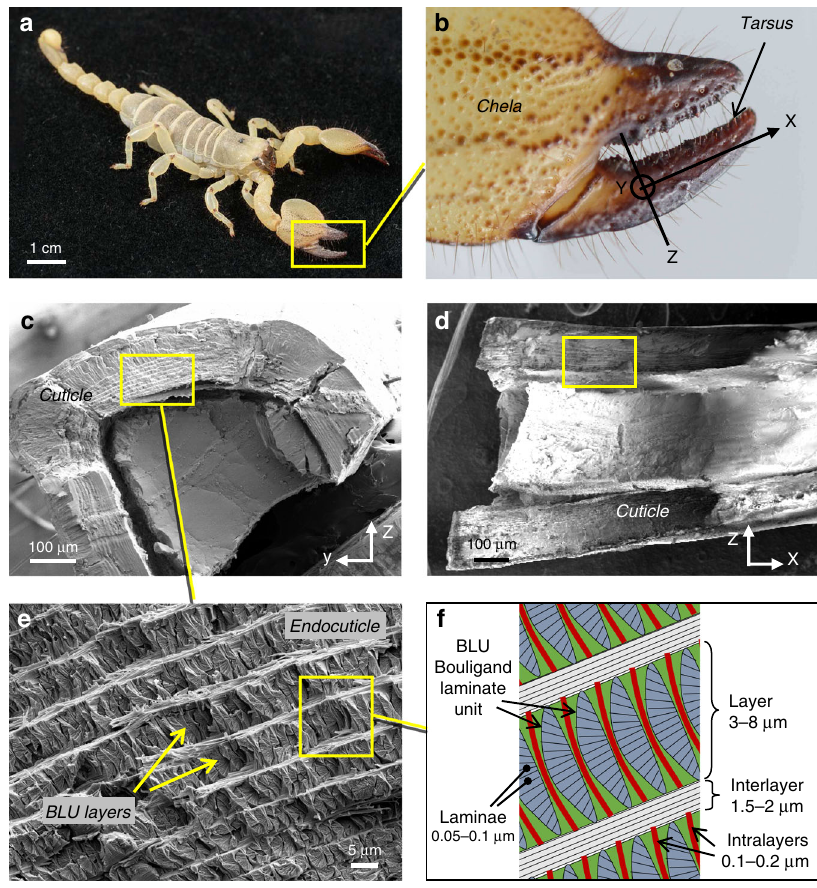
Fig. 1 Cross-sections through the scorpion tarsus. a Scorpio Maurus Palmatus . b Chela (pincer), tarsus (moveable claw) and axes de fi nition. c YZ transversal cross-section, focusing on the lower part of the tarsus. d XZ longitudinal cross-section, focusing on the upper part of the tarsus. e SEM magni fi cation of the yz cross-section showing the endocuticle and BLU (Bouligand laminate unit) layers. f De fi nition of